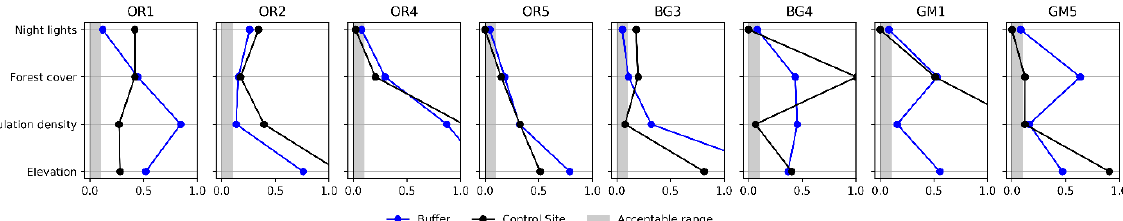
Fig. A4.1: Covariate bias for each covariate used in the first-stage Control site selection. The horizontal axes plot the absolute standardized mean difference (AMSD; Equation 1 in the main